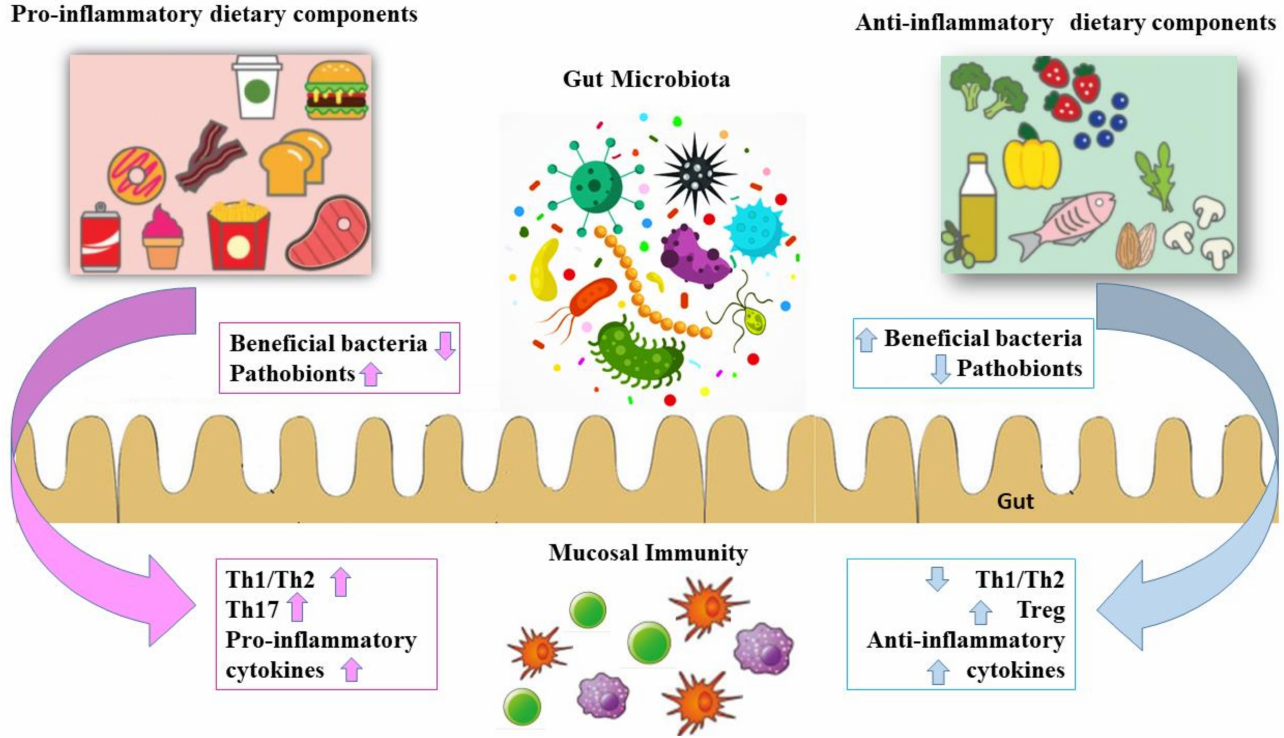
Figure 1. Diet plays a critical role in intestinal homeostasis, which is defined by the gut microbiota, intestinal mucosal barrier, and mucosal immune system. Diet directly modulates the mucosal barrier and immunity, whereas diet–microbiota interaction also regulates intestinal homeostasis. The up arrow indicates an increase while the down arrow indicates a